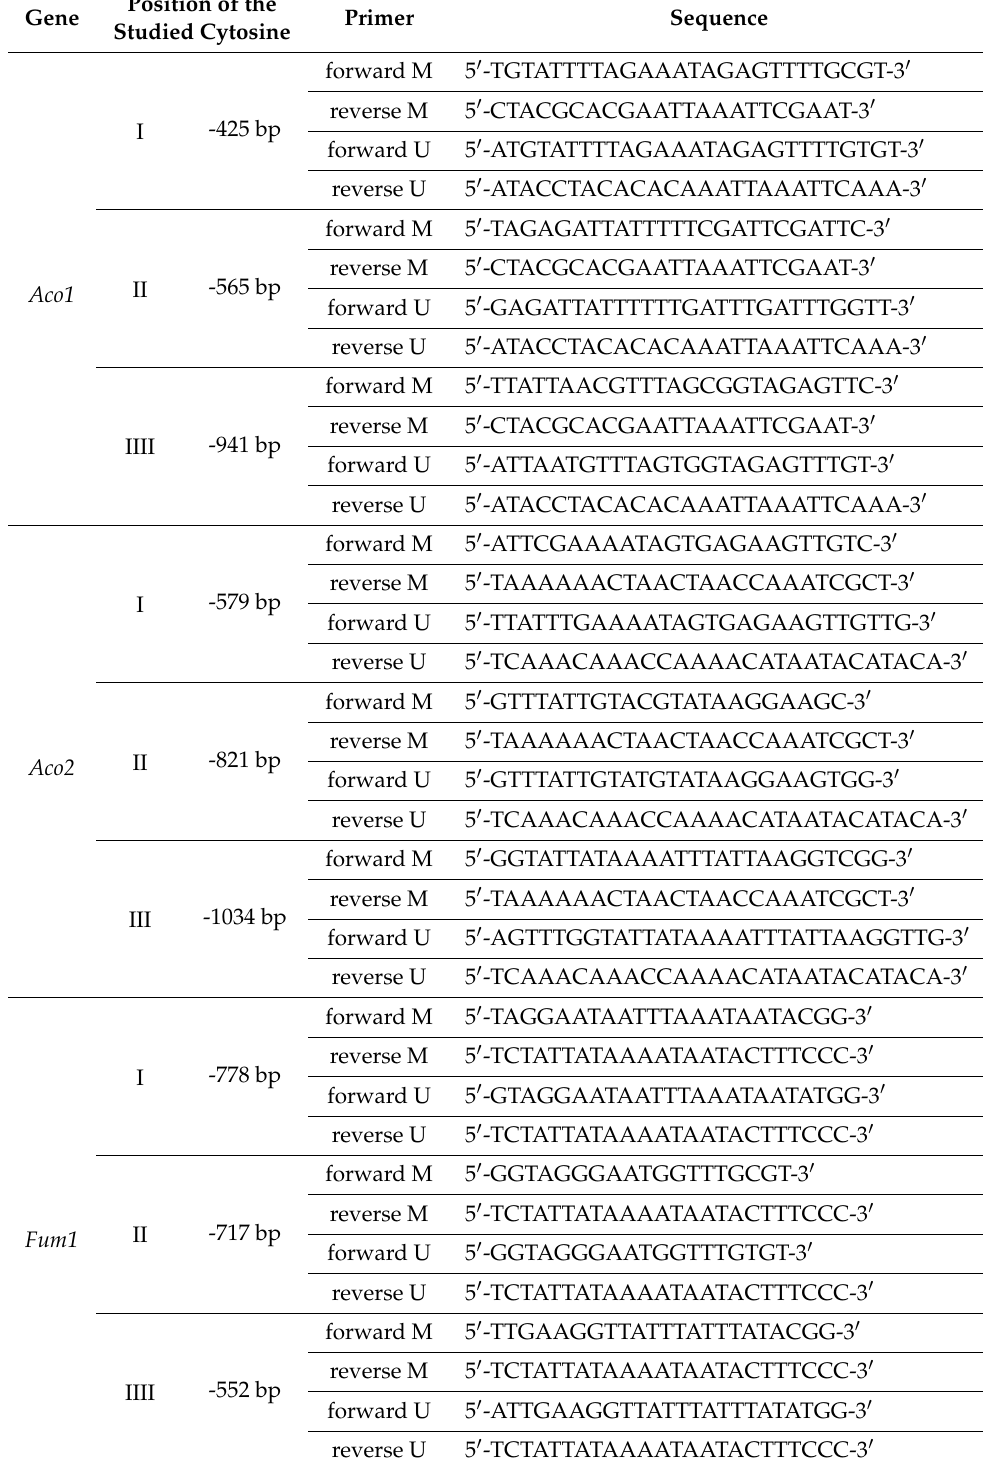
Table 2. Oligonucleotides for methyl-specific